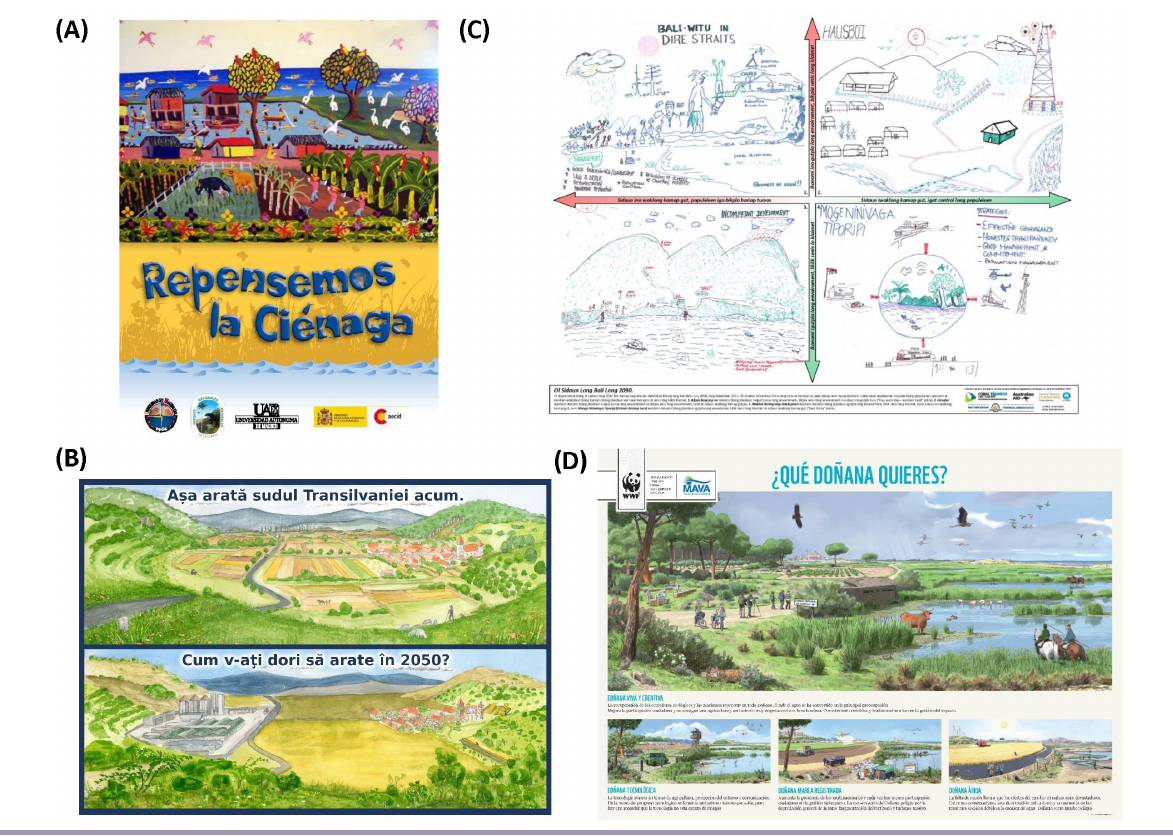
Fig. 4 . Examples of outreach material used for communicating scenarios results: (A) leaflet of the Ciénaga Grande of Santa Marta case in Colombia (#13); (B) postcard of the Southern Transylvania case in Romania (#15); (C) poster of the drawing of the four scenarios of the Papua New Guinea case (#18); and (D) poster of the social-ecological system of Doñana Protected Area case in Spain